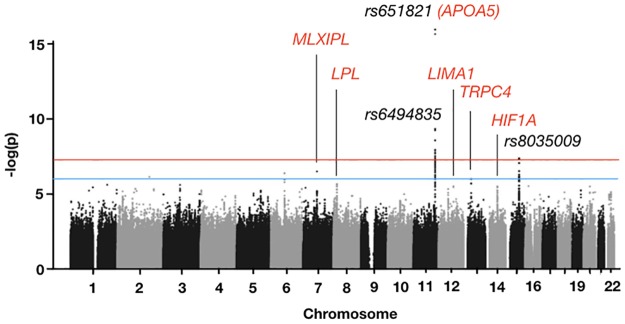
Manhattan plot representing the SNPs associated with the Cluster 2 phenotype.The three highly significant SNPs are shown in black. SNPs within known genes are represented by their gene names, colored in red.